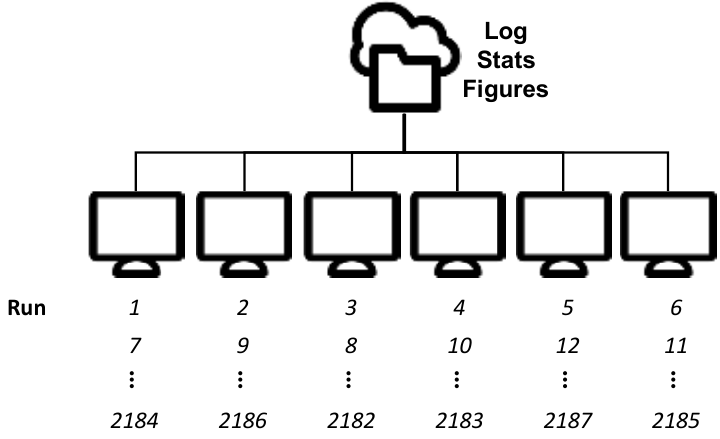
Figure 3. Conceptual representation of the computer cluster used to perform parallel runs.